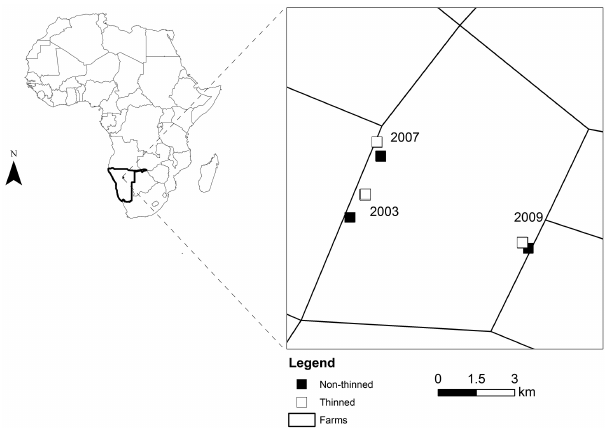
Figure 1. Map of study